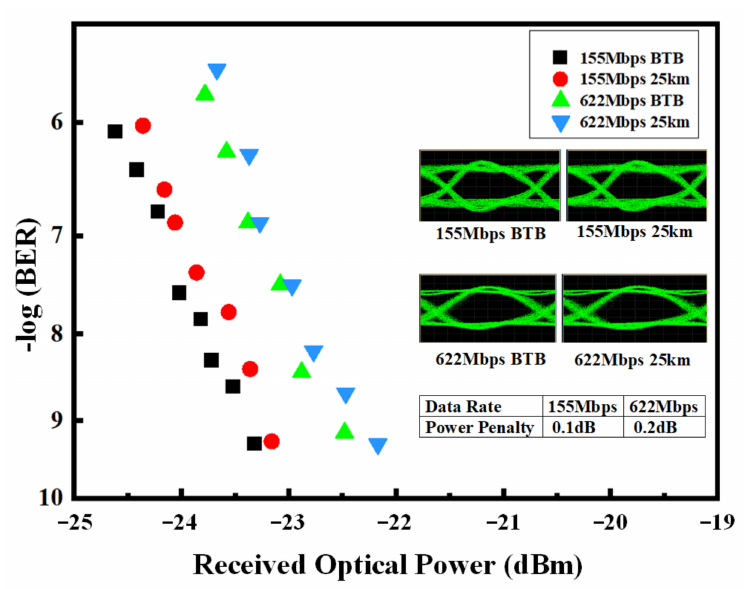
Figure 8. Comparison of BER curve and eye diagram for BTB and 25 km transmission.